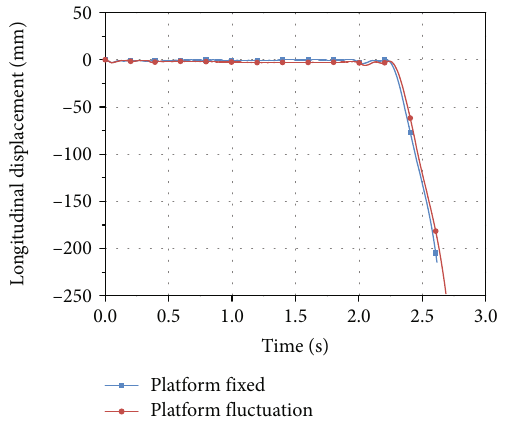
Figure 21: Longitudinal displacement of missiles under two platforms.